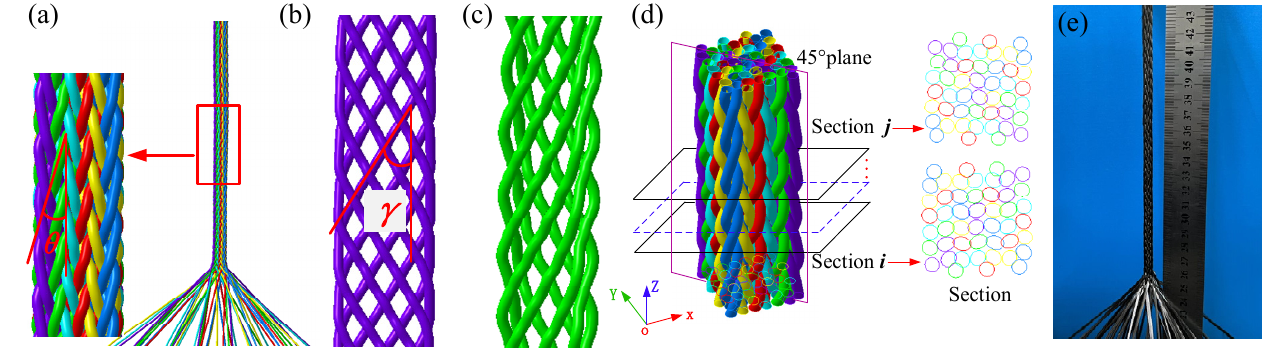
Figure 4. The braiding simulation results: ( a ) the simulation preform, ( b ) the yarn path in group 1, ( c ) the yarn path in group 5, ( d ) the pitch length calculating method, and ( e ) the test specimen.